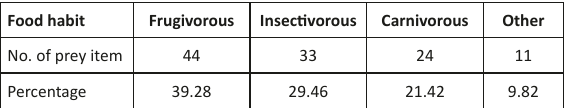
Table 3. Percentage of food items according to the food habits of Common Palm Civet. Food